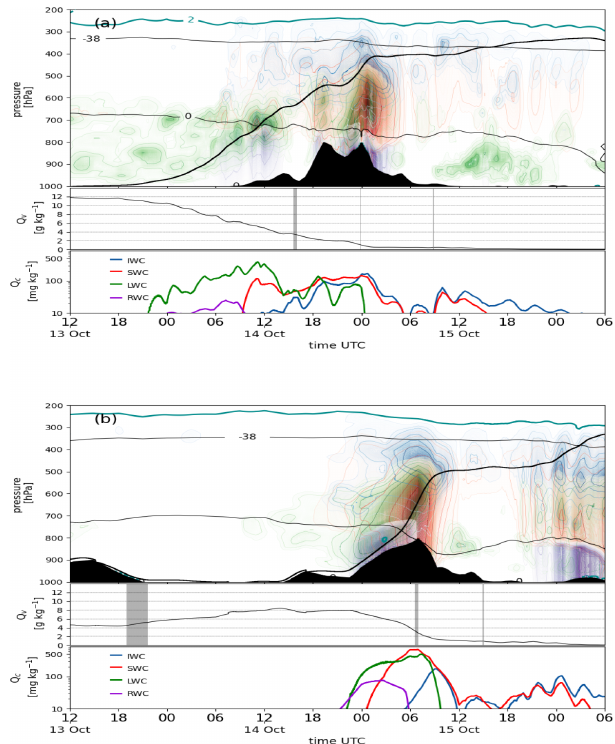
Figure 7. Vertical profiles along trajectories (a) T1 and (b) T2 (black lines in Fig. 6). In the upper portions of panels (a) and (b) are shown the height of the trajectory (thick black line), cloud species from EDA (rain water content (RWC) in purple with contours be- tween 10–100mgkg − 1 , LWC in green with contours between 10– 300mgkg − 1 , SWC in red with contours between 10–100mgkg − 1 and IWC in blue with contours between 10–100mgkg − 1 ), temper- ature (thin black lines for 0 and − 38 ◦ C), the 2PVU tropopause (cyan line) and orography (black areas). The middle portions of the panels show specific humidity Q v along the trajectories, and grey vertical bars indicate where measurements were taken. The lower portions of the panels show cloud species along the trajectories (see legend for